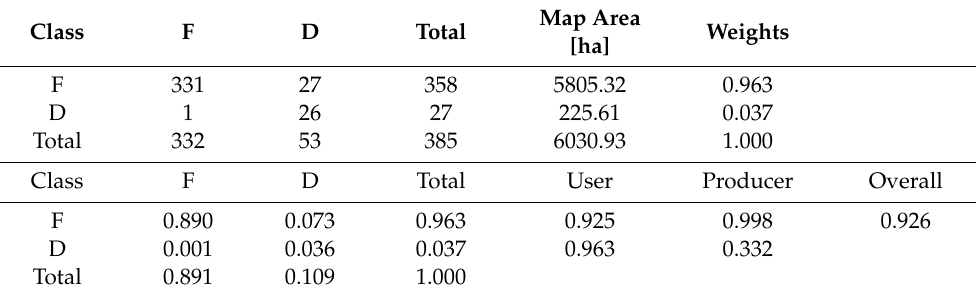
Table A7. “Optical Only” Peru disturbance method validation (only forest